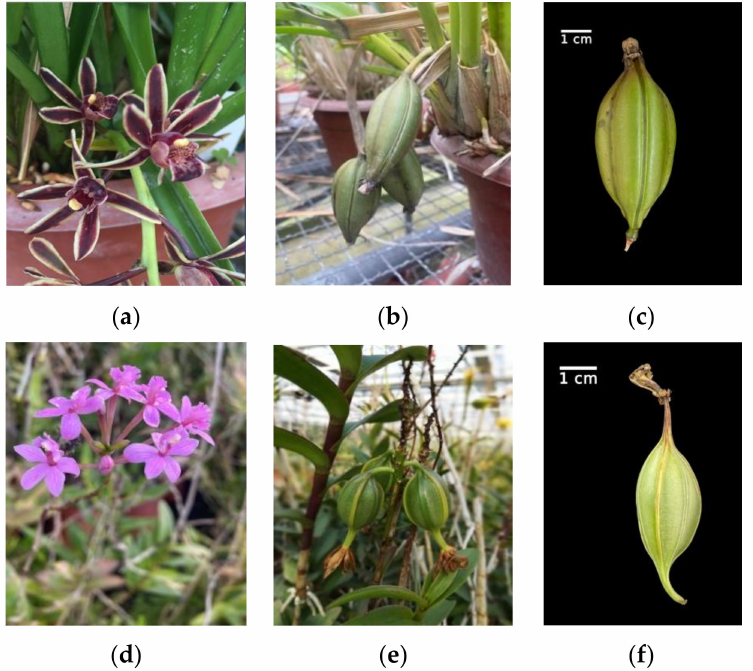
Figure 1. Flowers and capsules of Cymbidium mannii and Epidendrum radicans . ( a ) The flowers of C. mannii . ( b , c ) The capsules of C. mannii . ( d ) The flowers of E. radicans . ( e , f ) The capsules of E. radicans